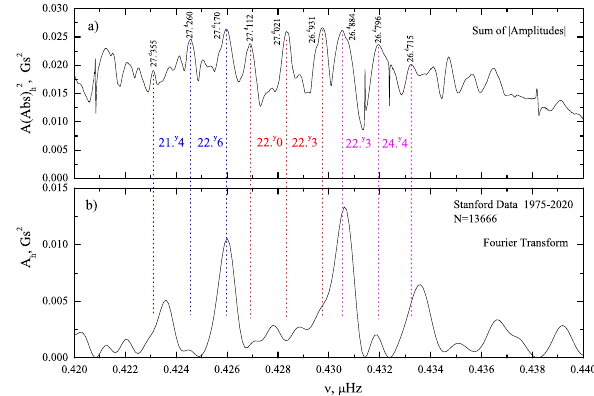
Figure 9. Power spectra of the MMF in a narrow range of the solar rotation periods: a) the spectrum is calculated by the formula (6), b) the usual spectrum is calculated by the formula